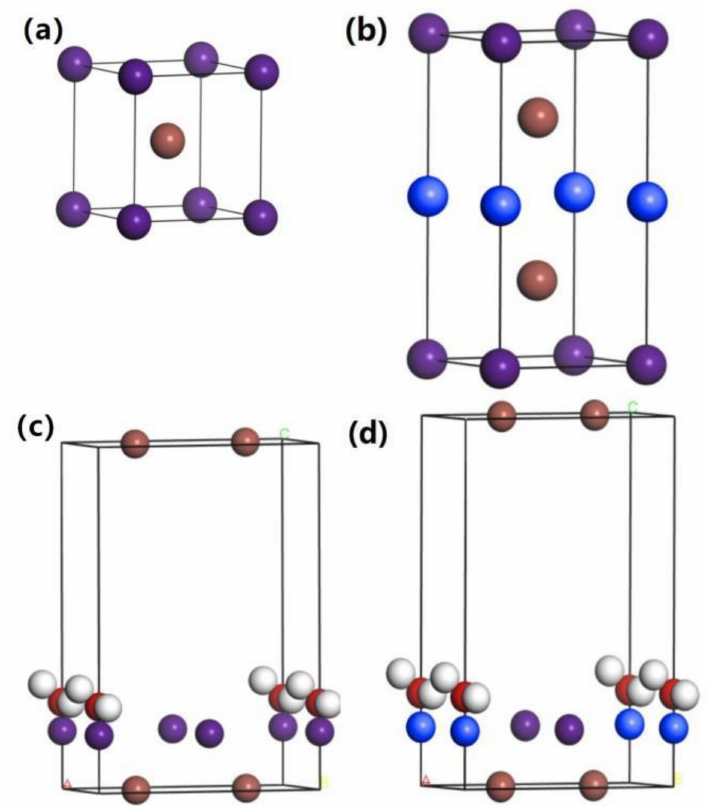
Figure 1. The computing models of the CsI crystals ( a ), CsI(Na) crystals ( b ), H 2 O molecules adsorbed on the CsI (010) surface ( c ) and H 2 O molecules adsorbed on the CsI(Na) (010) surface ( d ) (brown balls, purple balls, and blue balls represent I − , Cs + , and Na + ions,